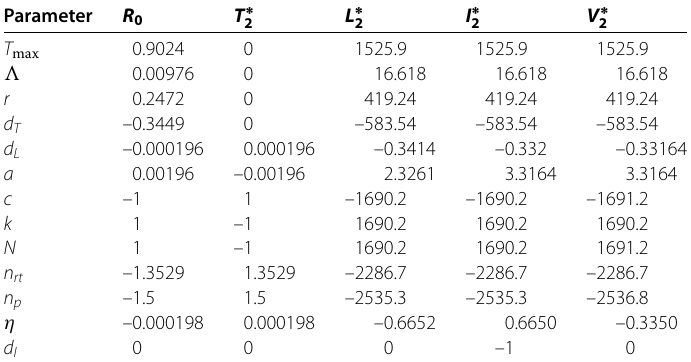
Table 13 Sensitivity indices for R 0 and for chronic infected T-cells and virus populations for R 0 ≈ 1 Parameter R 0 T ∗ L ∗ 2